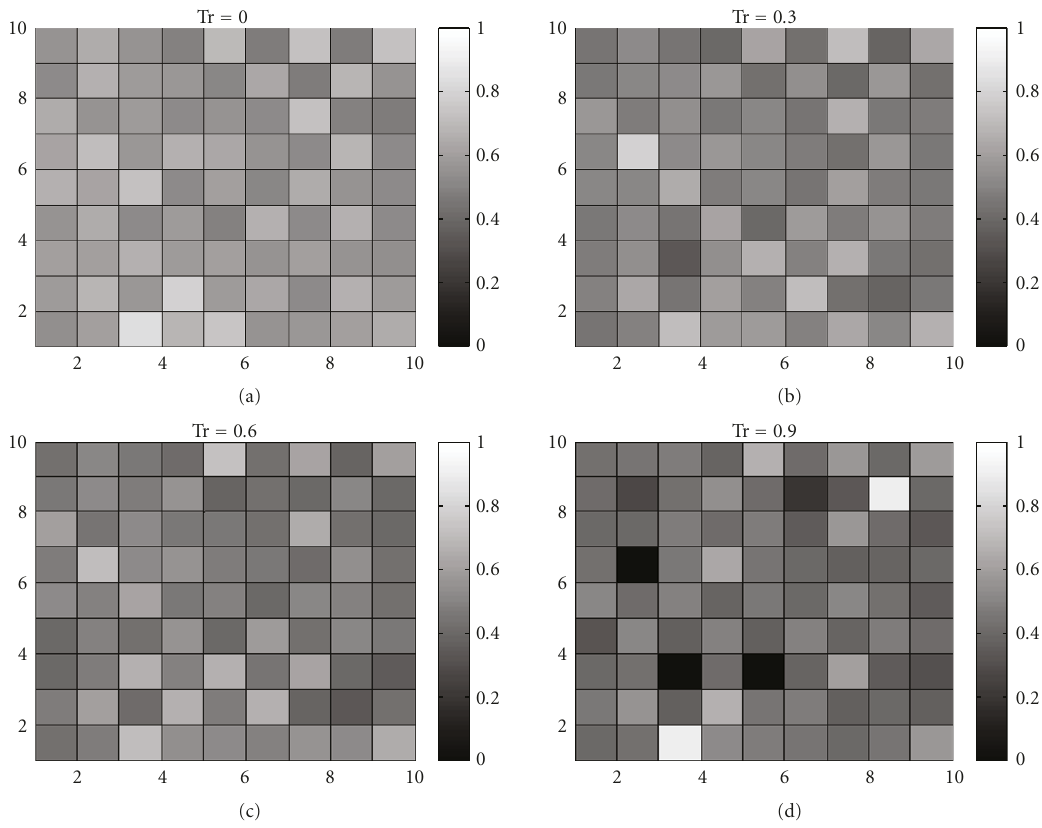
Figure 19: 3D illustration of spatial distribution of clustering coe ffi cient across the graph: dataset